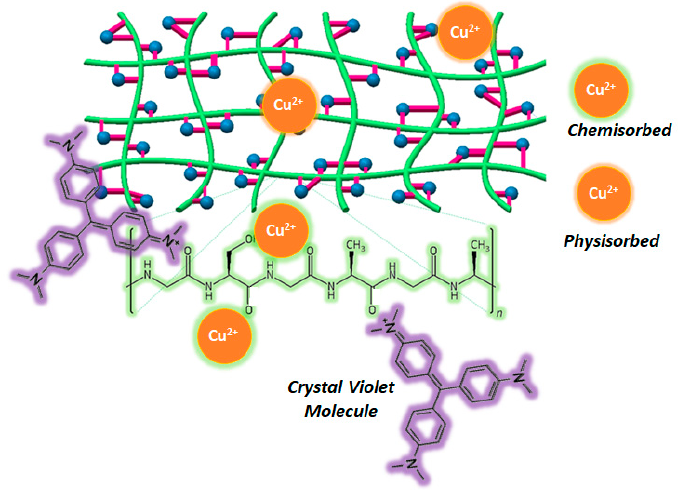
Figure 9. Schematic illustration of CV physisorption of CV and both physisorption and chemisorption of Cu 2+ on the surface of SF:SS biocomposite adsorbent.